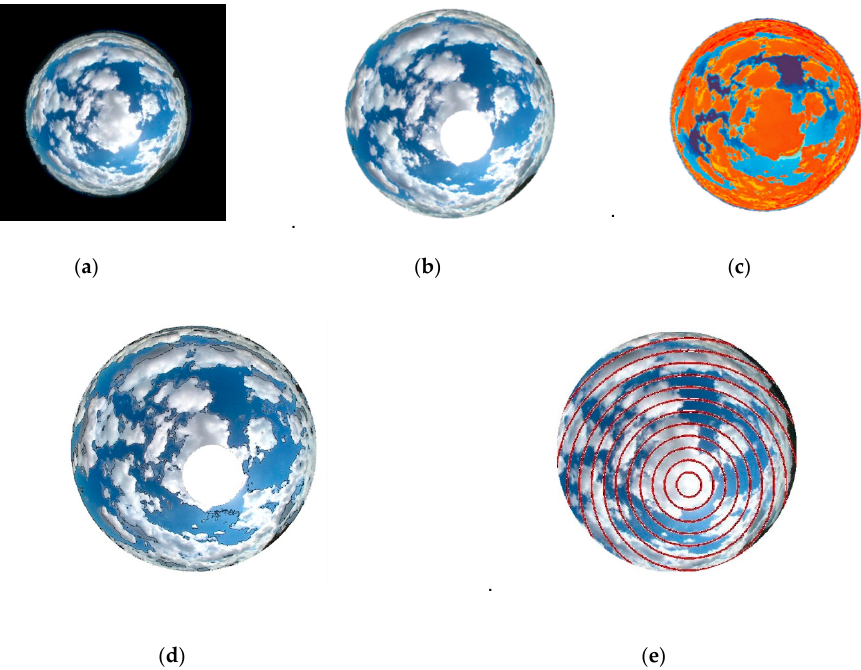
Figure 2. ( a ) Original image. ( b ) Cropped black area of the picture and coverage of the sun. ( c ) Haze Index image. ( d ) The picture from the Cloud Locating and Cloud Movement program. In addition, the black contour around the clouds show the possible clouds that could appear over the sun in the next minutes. ( e ) The picture shows the circles from the center of the sun with uniform distance to the horizon.